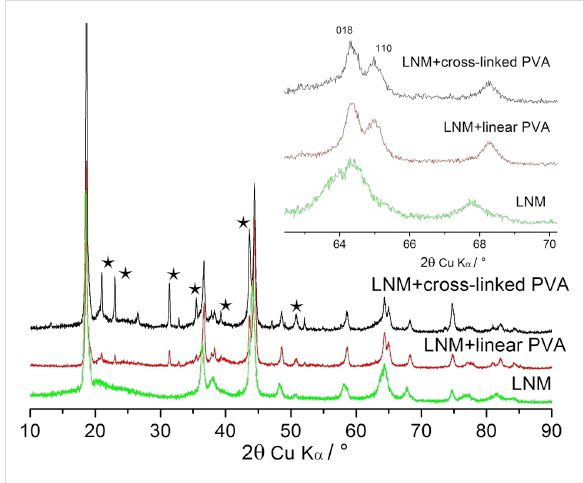
Figure 8: XRD patterns of pure and carbon-coated Li 1.4 Ni 0.5 Mn 0.5 O 2+ x after electrochemical cycling at 20–100 mAh·g − 1 . The asterisks denote reflections of Li 2 CO 3 (PC PDF